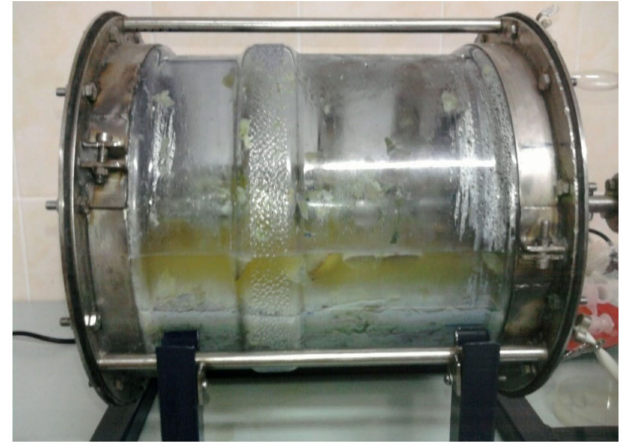
Figure 2. A 20-L bioreactor used for the dark fermentation of food